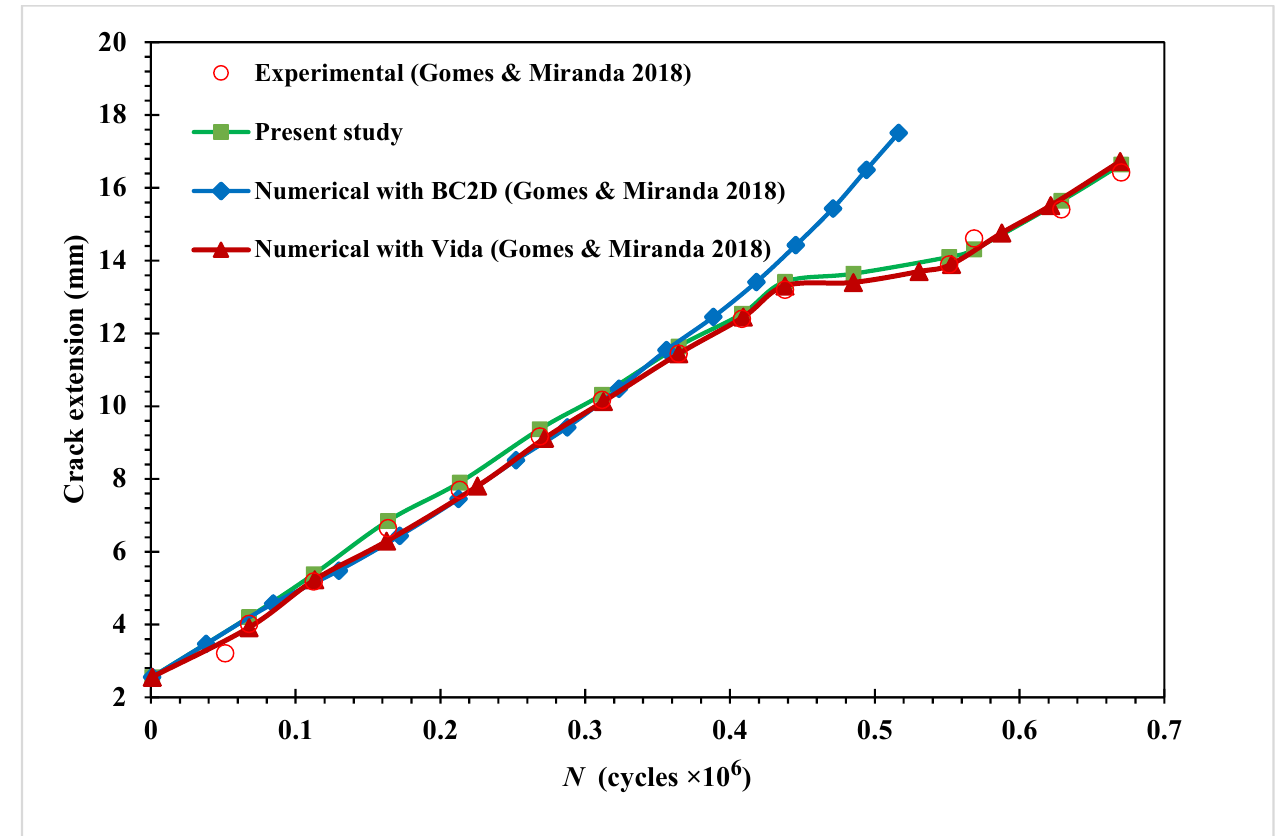
Figure 21. Modified four-point bending beam fatigue life comparison with [27].